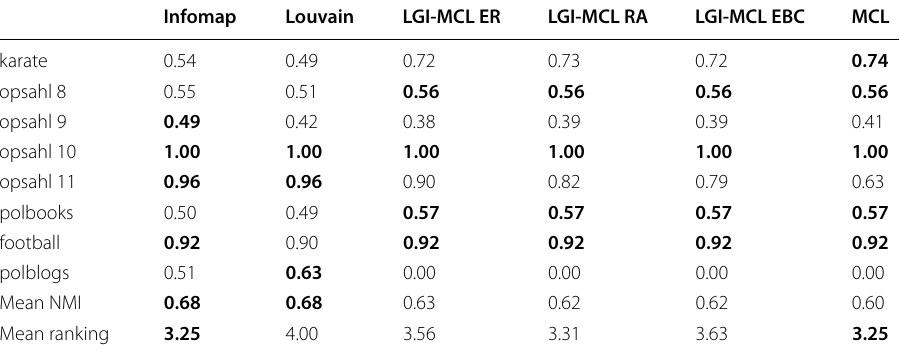
Table 3 Community detection on real networks perturbed with random removal of links